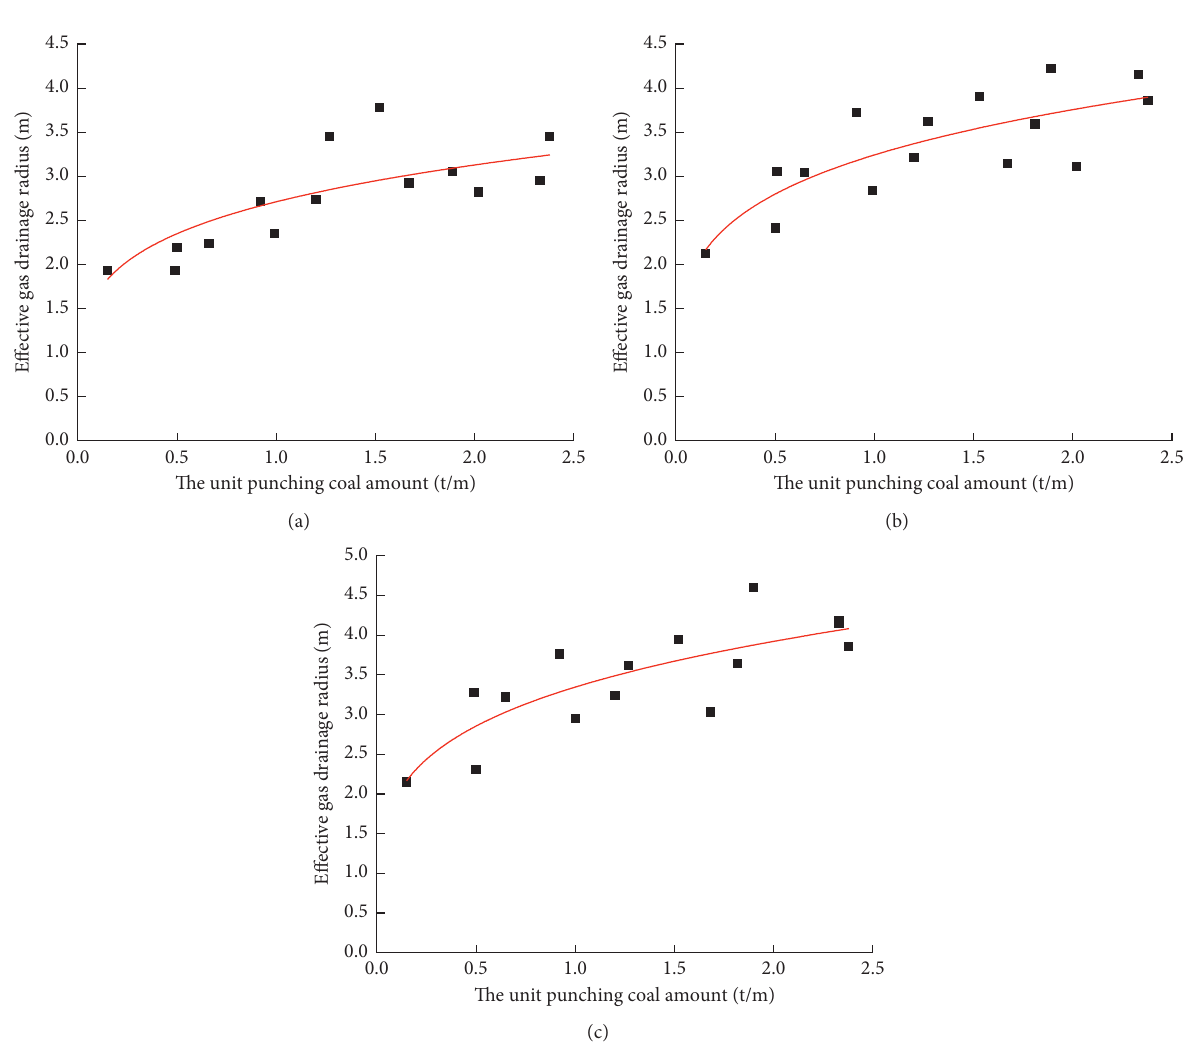
Figure 6: Correspondence between different coal output in different extraction periods and effective extraction radius. (a) 30 days. (b) 90 days. (c) 180 days. Table 2: Parameters of effective extraction radius in different periods of the borehole with different coal outputs. Effective borehole extraction radius (for different gas extraction time periods) Coal output (t/m) 30 days